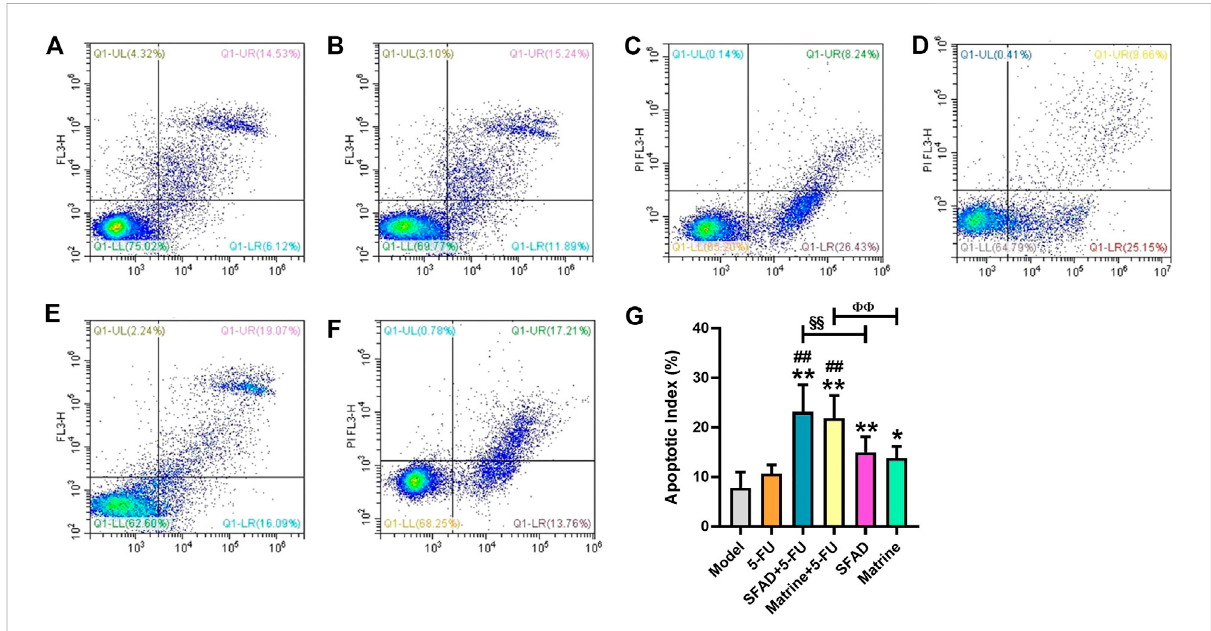
FIGURE 6 Effects of SFA/matrine+5-FU on the apoptotic index of tumor cells in BGC-823-transplanted nude mice. (A) Model control (negative control). (B) 5-FU control (0.01 g/kg) (positive control). (C) SFAD (0.2 g/kg)+5-FU (0.01 g/kg). (D) Matrine (4.03 mmoL/L)+5-FU (0.01 g/kg). (E) SFAD (0.2 g/kg). (F) Matrine(4.03mmoL/L). (G) Apoptoticindexoftumorcells(%).Dataarepresentedasthemean±SDofeightnudemice.* p < 0.05,** p < 0.01 vs. the model group; ## p < 0.01 vs. the 5-FU group; §§ p < 0.01 for the SFAD+5-FU vs. SFAD groups; ΦΦ p < 0.01 for the matrine+5-FU vs. matrine groups (one-way